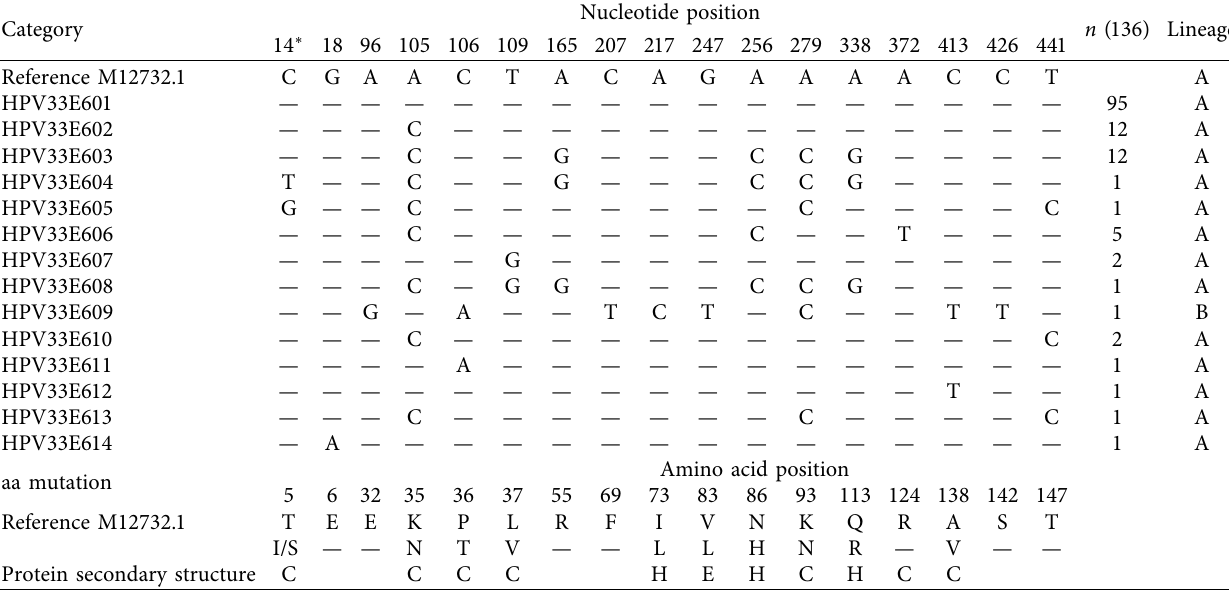
Table 4: Nucleotide sequence mutations of HPV33E6.